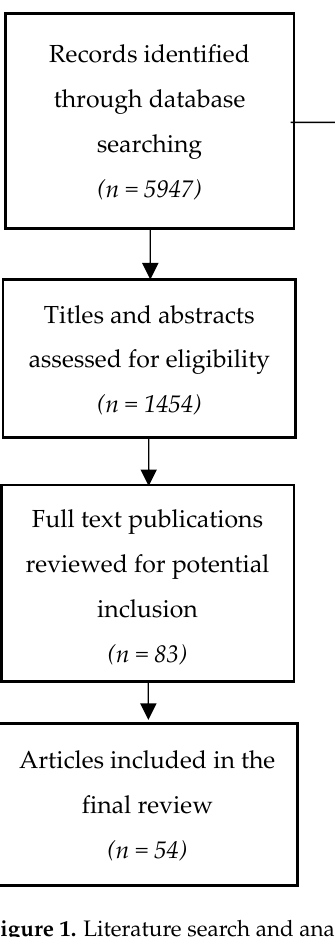
Figure 1. Literature search and analysis.